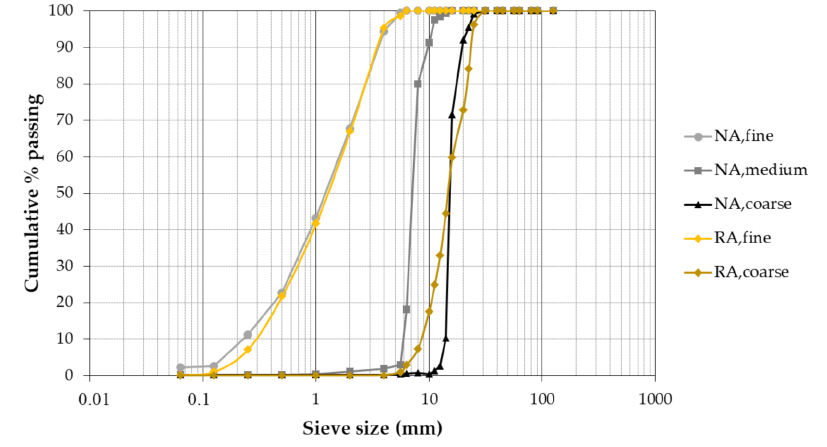
Figure 5. Particle size distribution of natural aggregates (NA) and recycled aggregates